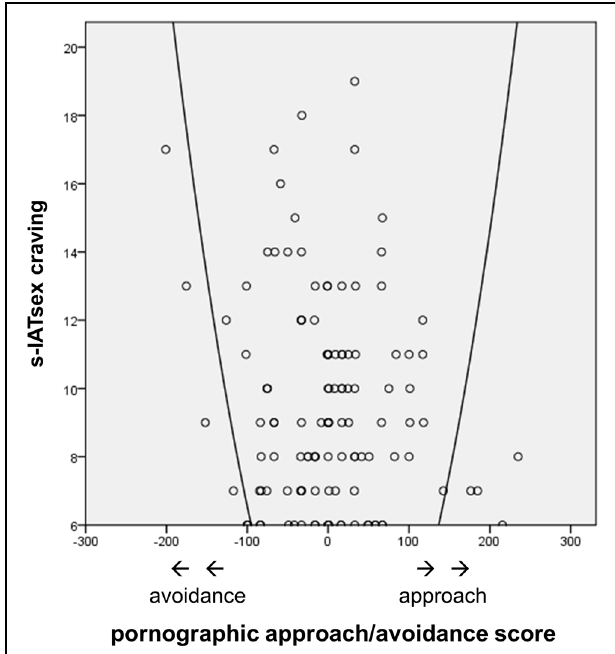
FIGURE 2 | Relationship between the compatibility effect score for pornographic pictures (pornographic approach/avoidance score) and the s-IATsex factor